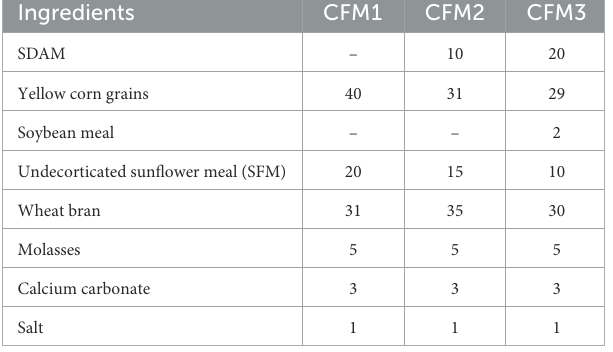
TABLE 1 Ingredient composition (%) of different concentrate feed mixtures (CFM).